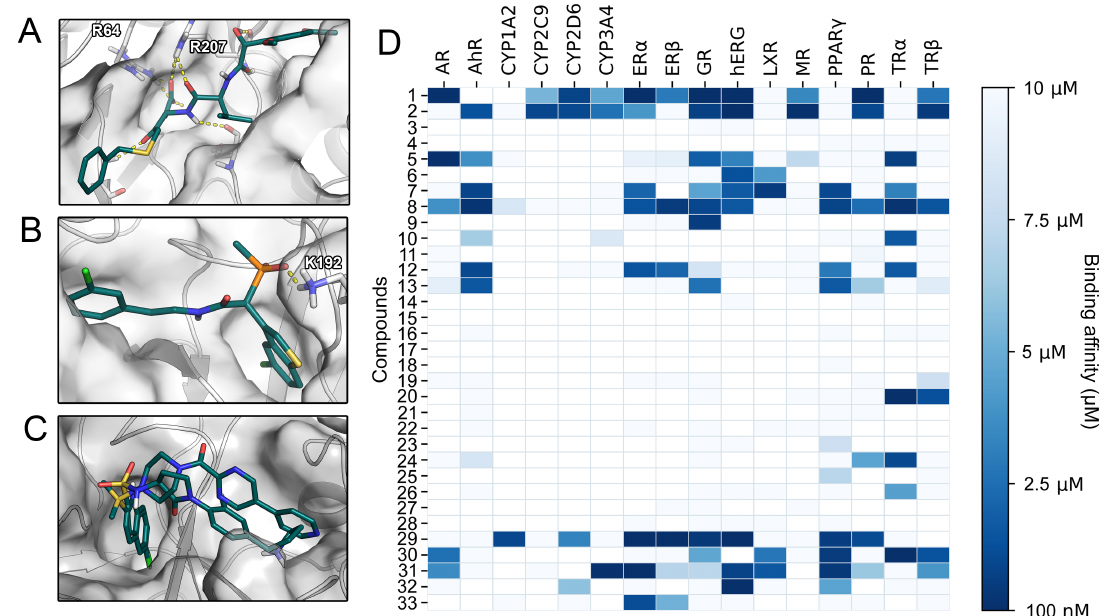
Figure 5. ( A ) Binding mode of compound 86 toward caspase-3. ( B ) Binding mode of compound 293 toward chymase. ( C ) Binding mode of compounds 130 and 137 toward factor Xa. ( D ) SARS-CoV-2 M pro inhibitors examined with VTL. The predicted binding affinities of the assessed compounds 1-33 for 16 anti-targets are